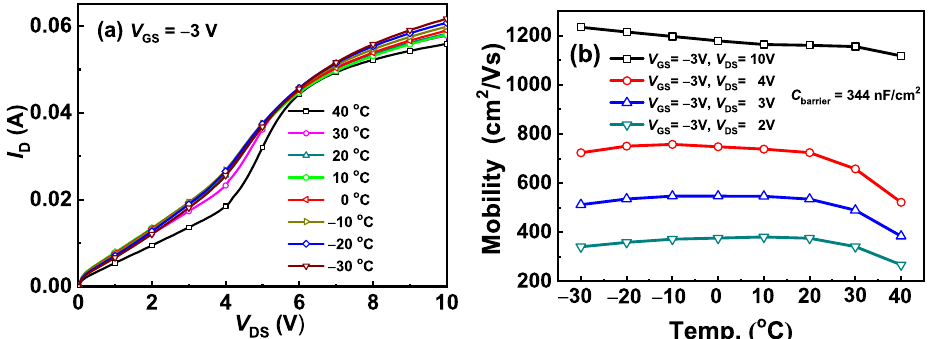
Figure 5. Temperature -dependent I-V characteristics ( a ) and extracted carrier mobility ( b ) of the fabricated AlGaN/GaN HEMTs at various drain